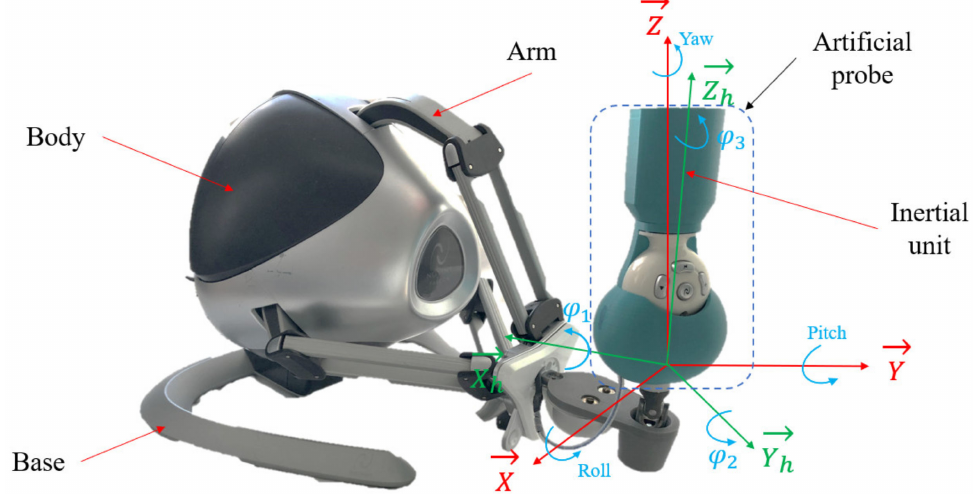
Figure 4. 6-DoF hybrid haptic interface.